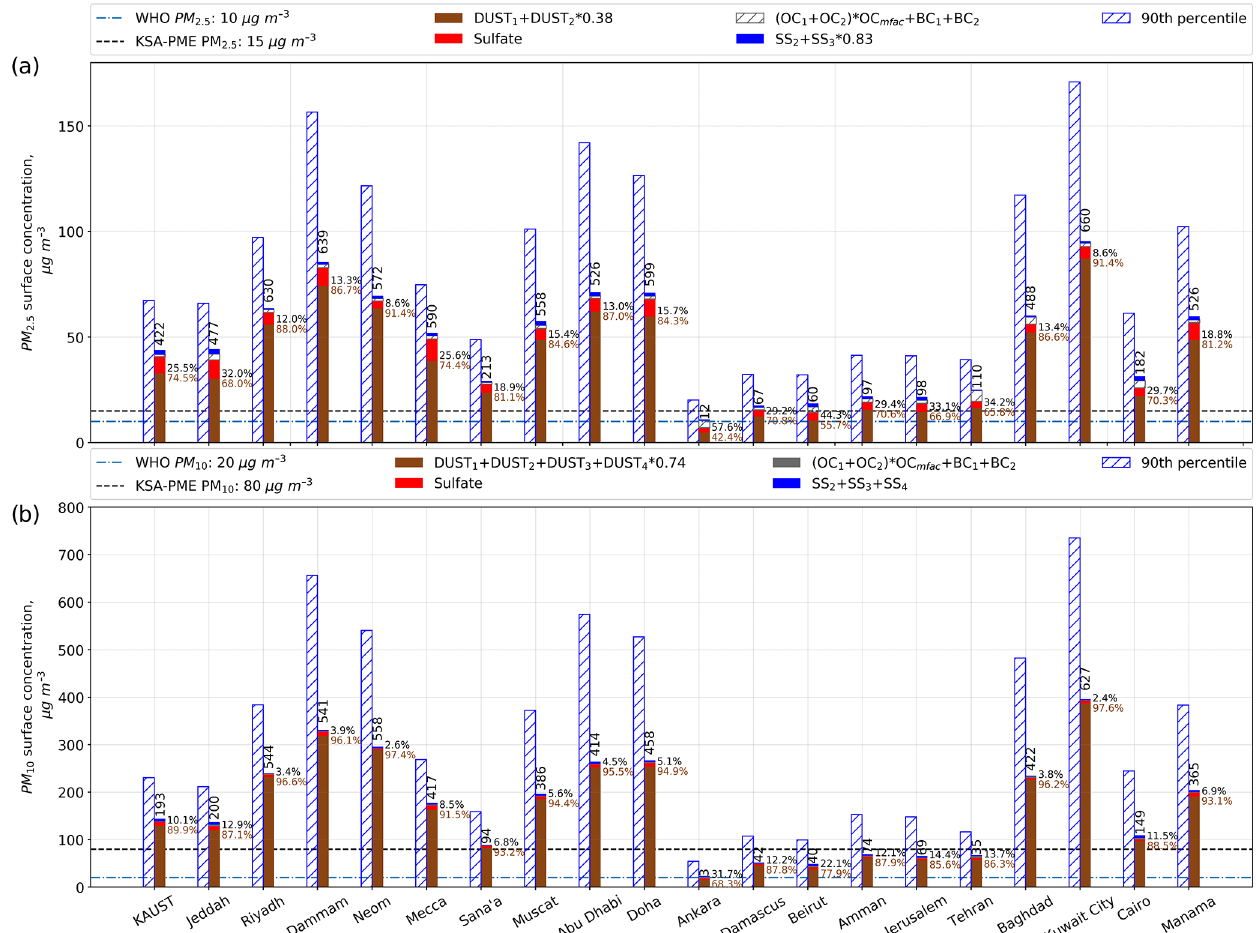
Figure 11. Annual mean 2015–2016 PM surface concentrations (µgm − 3 ) calculated for the major ME cities and PM decomposition into dust and nondust (sulfate, sea salt, black carbon, and organic matter) components (stacked bars). Abbreviations of the aerosols’ names correspond to those given in Sect. 5.3. Hatched bars denote 90th percentiles (µgm − 3 ) calculated using daily mean PM concentrations. WHO guidelines and KSA-PME air quality limits for annually averaged PM are shown by dash-dotted and dashed lines. Numbers over the stacked bars correspond to the number of days during 2015–2016 when daily averaged PM surface concentration exceeded the US EPA air quality limit. (a) PM 2 . 5 ; the daily averaged US EPA air quality limit is 35µgm − 3 , and the annual WHO guideline and KSA-PME limit are 10 and 15µgm − 3 , respectively. (b) PM 10 ; the daily averaged US EPA air quality limit is 150µgm − 3 , and the annual WHO and KSA-PME limits are 20 and 80µgm − 3 ,